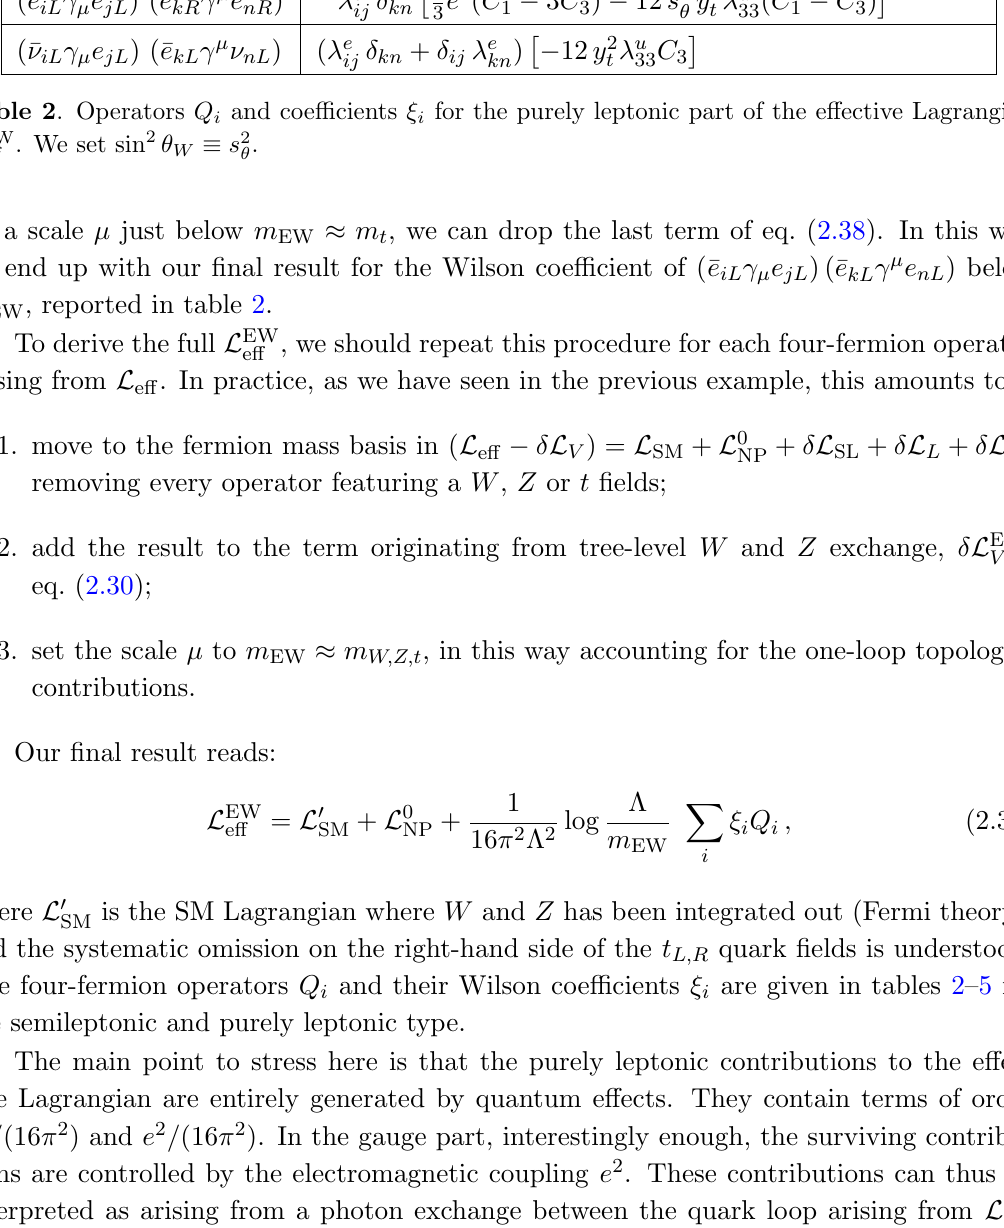
(cid:13) e ) ((cid:22) e (cid:13) (cid:22) e ) (cid:22) iL jL nL kL